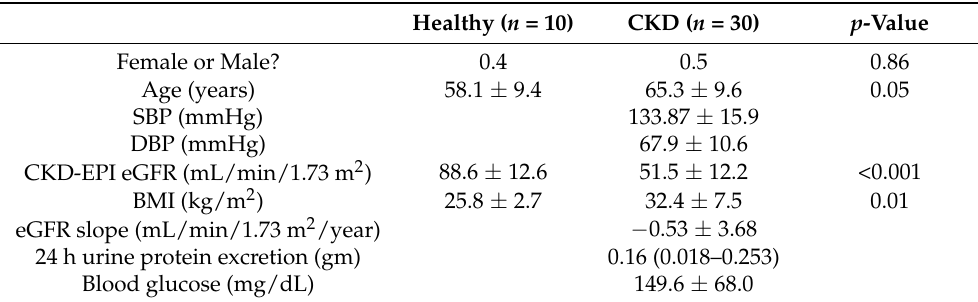
Table 1. Baseline characteristics of healthy and CKD